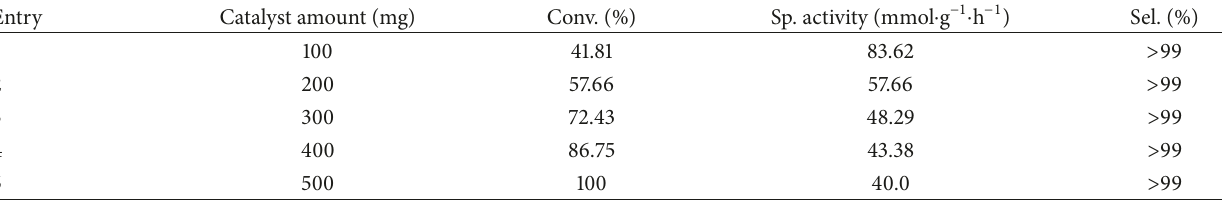
Table 4: Effect of catalyst amount in oxidation of 1-phenylethanol. [ a ]